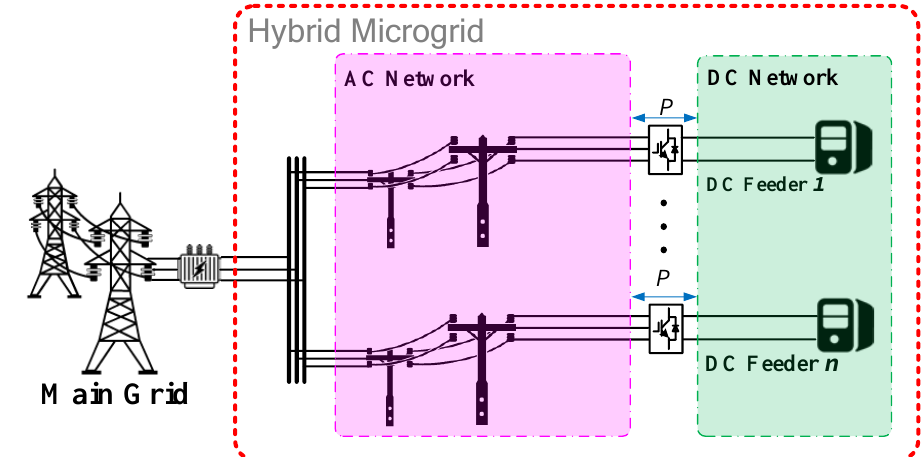
Figure 2. The proposed planning framework of the hybrid MGs.